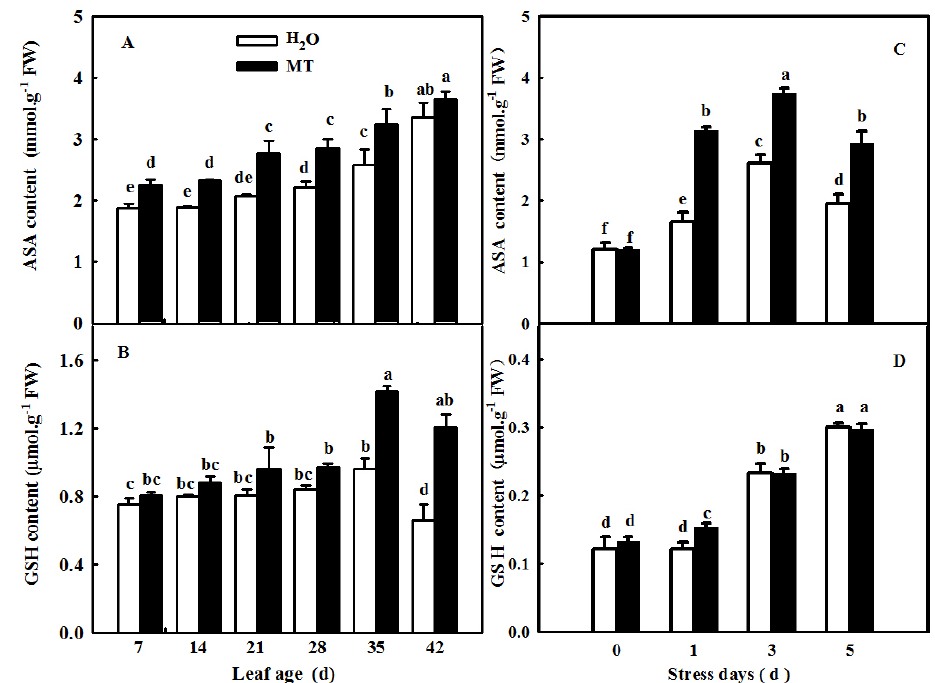
Figure 12. The effect of exogenous MT on the ASA and GSH contents in senescent leaves of cucumber plants induced by age or darkness. ( A , B ) ASA and GSH contents in different age leaves; ( C , D ) ASA and GSH contents in leaves under darkness. At the two-leaf stage, the cucumber seedlings were planted in a solar greenhouse or started to be treated with MT. At the three-leaf stage, the new leaf at the top of cucumber plants was labeled 0 days and then labeled at 7, 14, 21, 28, 35, and 42 days in a solar greenhouse; plants were sprayed with 100 μ mol·L − 1 MT every 7 days, and plants treated with H 2 O were the control. Meanwhile, the seedlings were treated with H 2 O and 100 μ mol·L − 1 MT, respectively, 2 times, and then seedlings were displaced into growth chambers and treated with dark condition (day/night temperature: 25 °C/18 °C). The 2nd leaf samples were taken at 0, 1, 3, and 5 days. All values shown are mean ± SD ( n = 3). a, b, c, d, e, and f indicate that mean values are significantly different among samples ( p < 0.05).